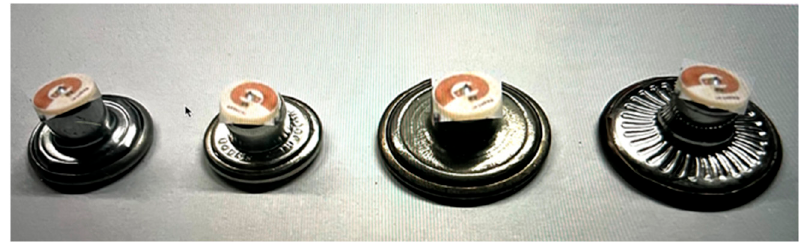
Figure 5. Button antenna; design based on